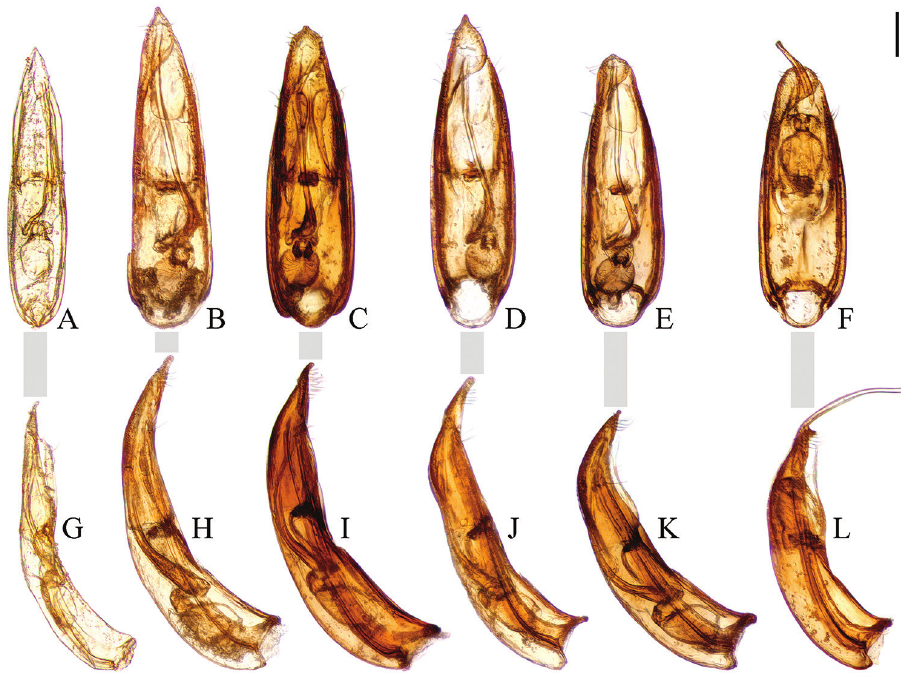
Figure 10. Aedeagi of Ptomaphagus (s. str.) spp. ( A–F dorsal view G–L lateral view) A, G P. (s. str.) pic- coloi Wang, Růžička, Nishikawa, Perreau & Hayashi, 2016 (China: Zhejiang) B, H P. (s. str.) sp.4 (China: Sichuan) C, I P. (s. str.) sp.5 (China: Shaanxi) D, J P. (s. str.) sp.6 (China: Sichuan) E, K P. (s. str.) sp.7 (China: Shaanxi) F, L P. (s. str.) sp.8 (China: Shaanxi). Scale bar: 0.1